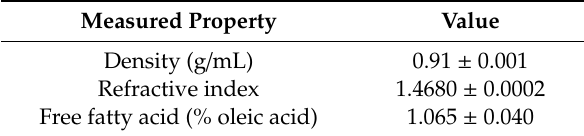
Table 4. Physical and physicochemical properties of the avocado